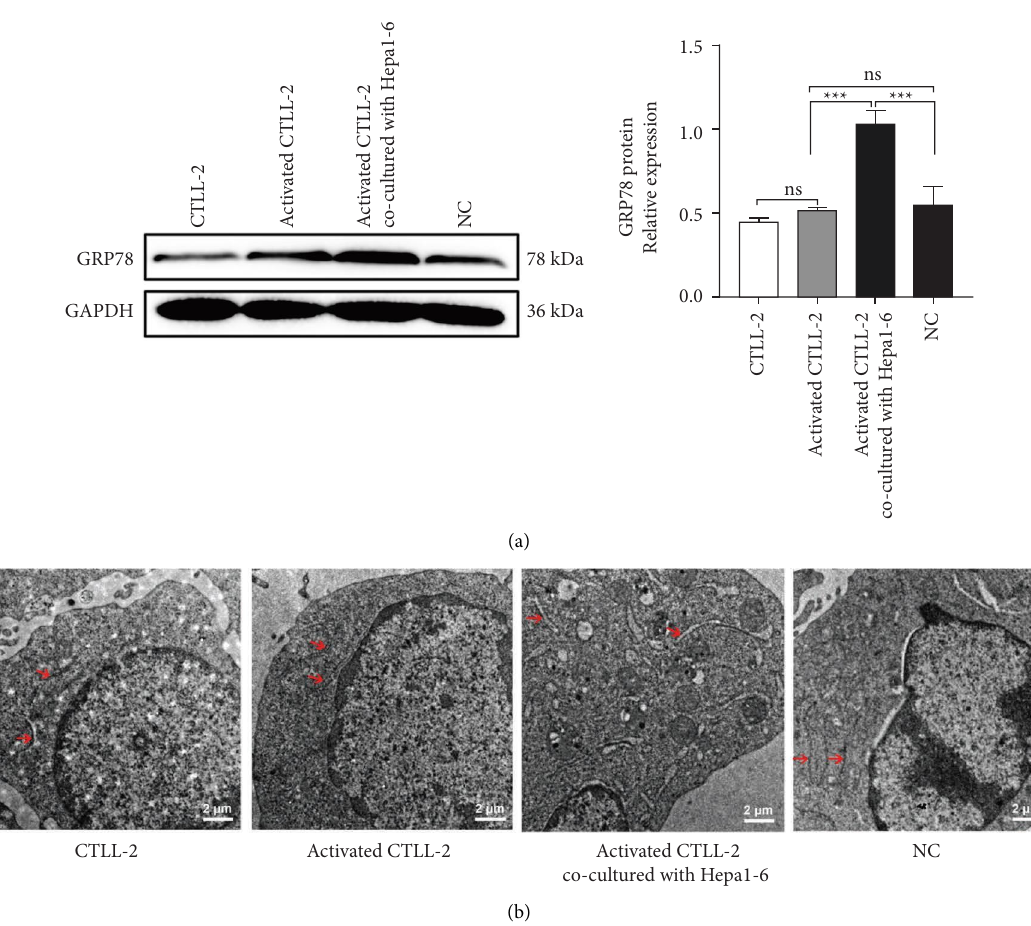
Figure 2: ER stress in CTLs was induced by hepatoma cells. (a) After coculturing hepatoma cells with CTLL-2 cells, GRP78 protein expression was detected by western blotting. (b) ER morphology was detected by electron microscopy (scale bar � 2 μ m). Data are presented as the mean ± SD. ∗∗∗ P < 0 . 001, ns indicates no statistical